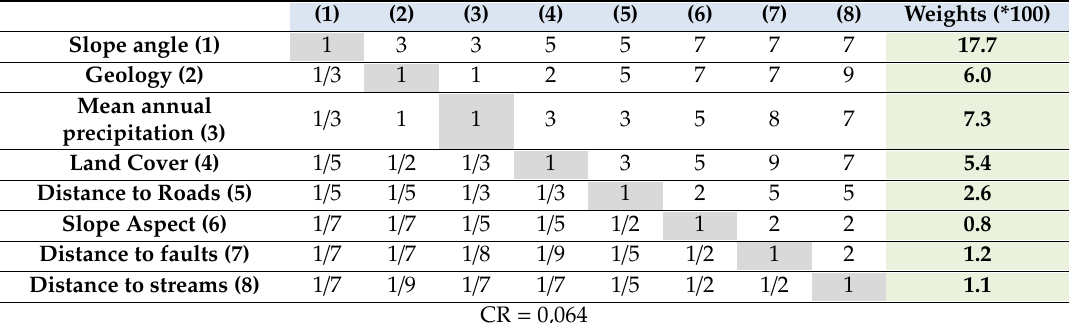
Table 2. The landslide causative factors’ pair-wise comparison matrix and weights (normalized principal eigenvector) for based on Analytical Hierarchy Process (AHP) method